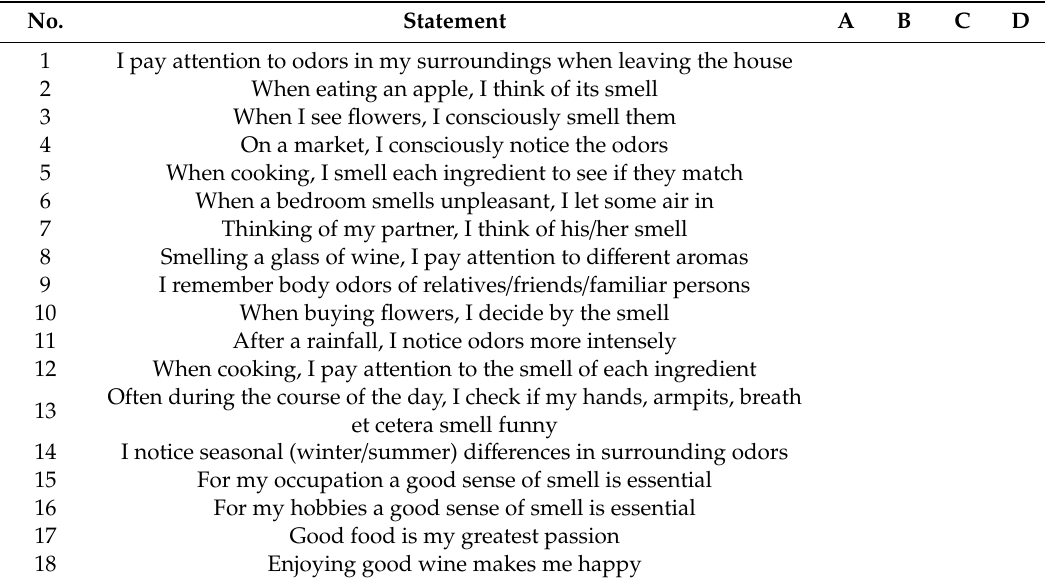
Table 2. Individual significance of olfaction: novel additional